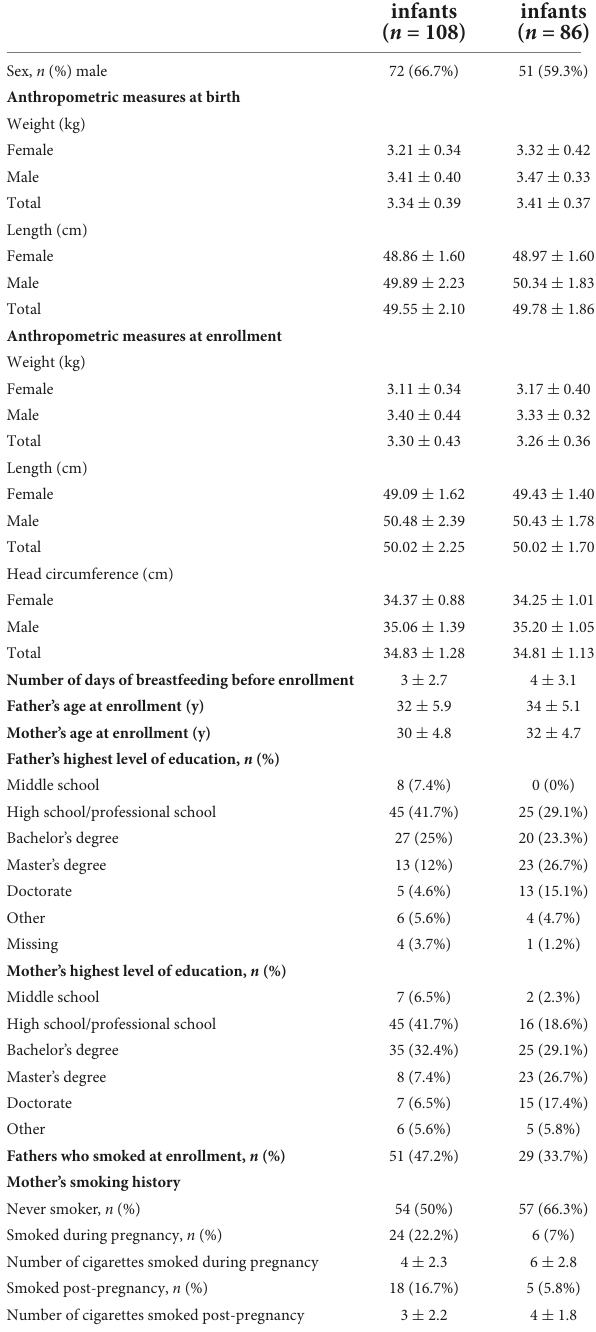
TABLE 1 Characteristics of study infants, by feeding group (ITT population).